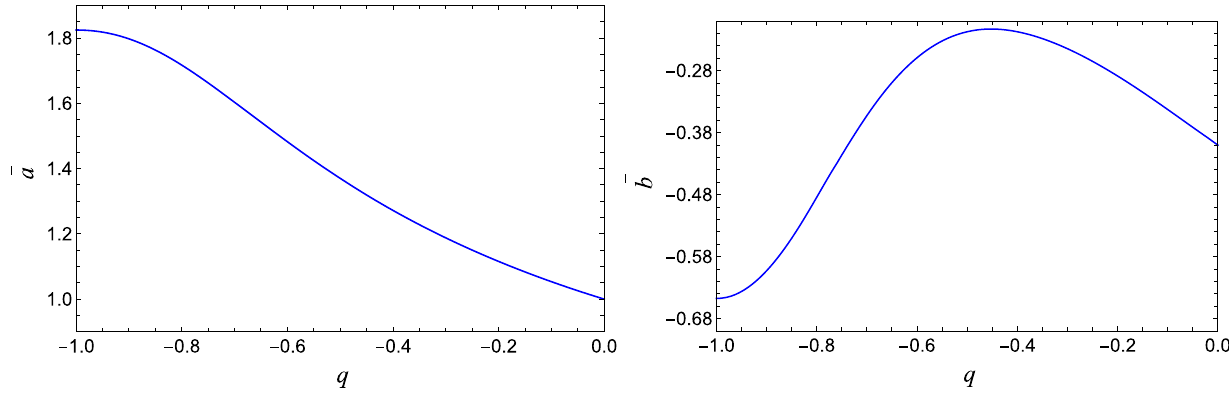
Fig. 5 The behavior of strong lensing coefficients ¯ a and ¯ b as a function of the hair parameter q . ¯ a = 1 and ¯ b = − 0 . 4002 at q = 0 correspond to the values Schwarzschild black hole